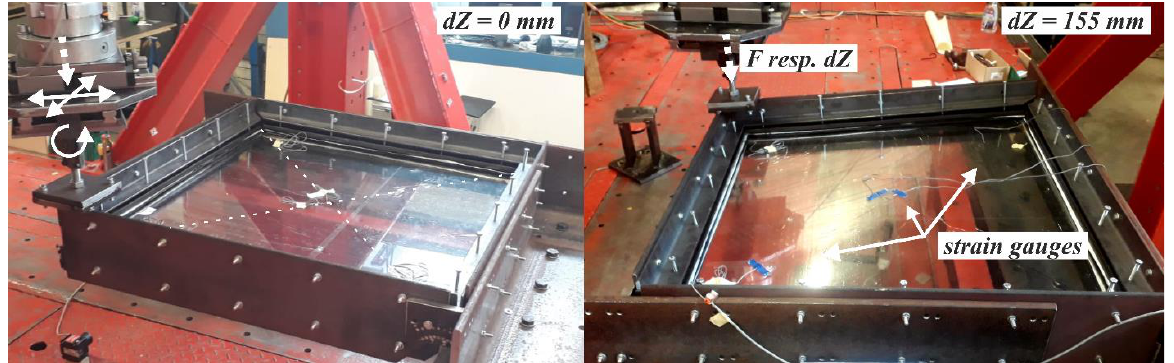
Fig. 2 Experimental test setup: (left) initial state and (right) post-bending state.